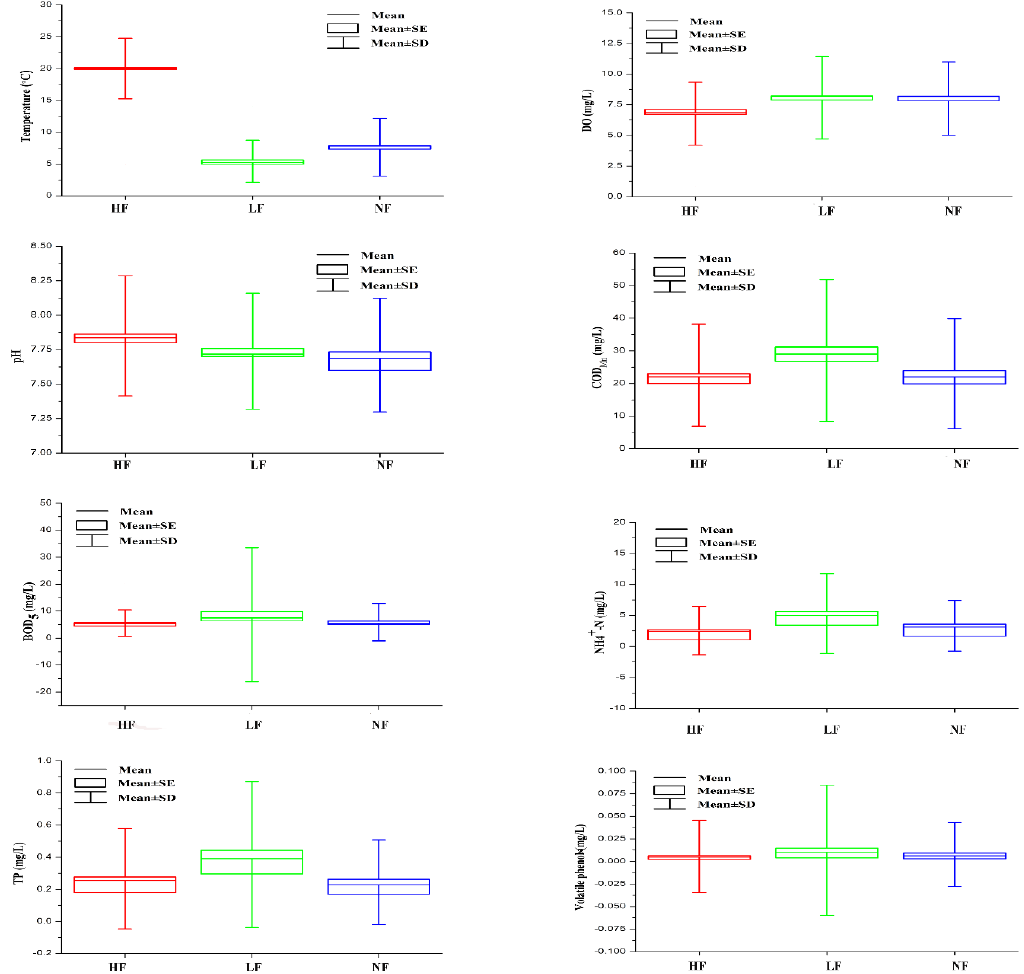
Figure 4. Box and whisker plots of discriminant parameters produced through temporal discriminant analysis. Note: SD and SE are the abbreviation of standard deviation and standard error, respectively. DO = dissolved oxygen, COD Mn = chemical oxygen demand, BOD 5 = 5-day biochemical oxygen demand, TP = total